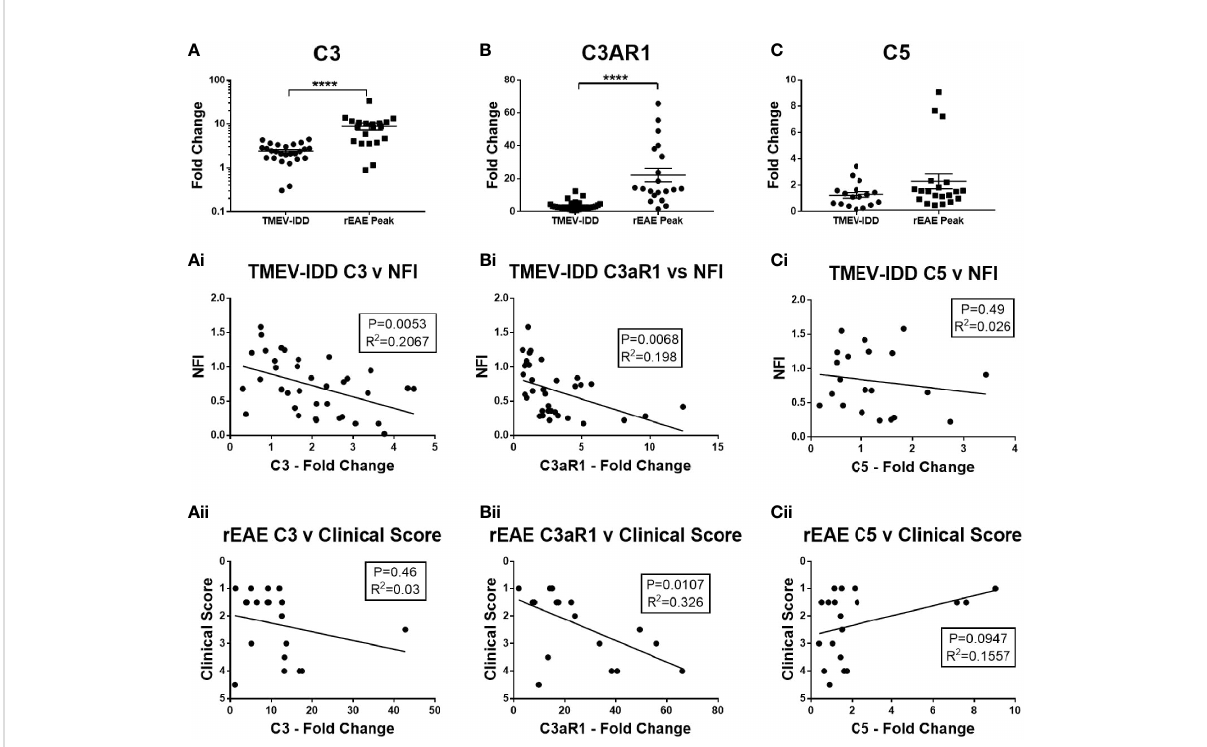
FIGURE 1 CNS gene expression of central complement components and their association with disease outcomes. Gene expression of C3, C3aR1, and C5 was determined by rt-PCR in spinal cords from TMEV-IDD mice (n =26) at day ~120 post-infection or rEAE mice (n =20) at day ~15 post- immunization. (A-C) Scatter plots display C3 (A) , C3aR1 (B) and C5 (C) in TMEV-IDD or rEAE mice with mean ± SEM for the group. Fold changes were calculated between diseased and age-matched sham mice. Signi fi cant differences are indicated by ****(P<0.0001) as determined by Mann-Whitney U-tests. Linear regression analysis shows that high C3 gene expression (Ai, Aii) correlates with a worse disease outcome in TMEV-IDD, but not in rEAE, while C3aR1 (Bi, Bii) relates to a worse disease outcome in both rEAE and TMEV-IDD. Finally, there is no signi fi cant correlation between C5 gene expression (Ci, Cii) and clinical outcome neither in TMEV-IDD nor in rEAE. P value and the coef fi cient of determination R 2 are indicated in each